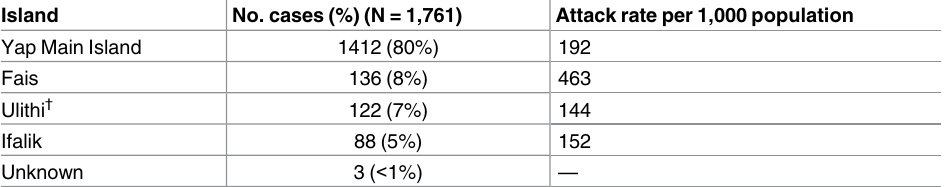
Table 2. Numbers of and attack rates for clinical cases presenting to a health care facility by island, Yap State, August 11, 2013–August10, 2014 * . Island